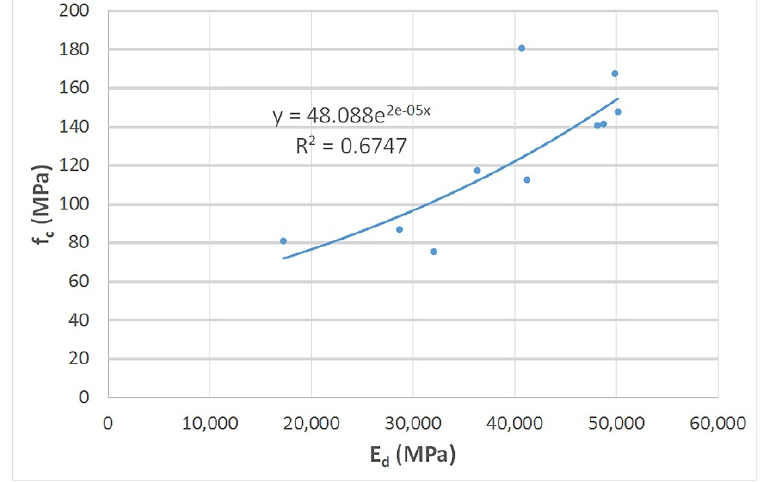
Figure 12. Exponential correlation between cylindric compression strength and dynamic elastic modulus.